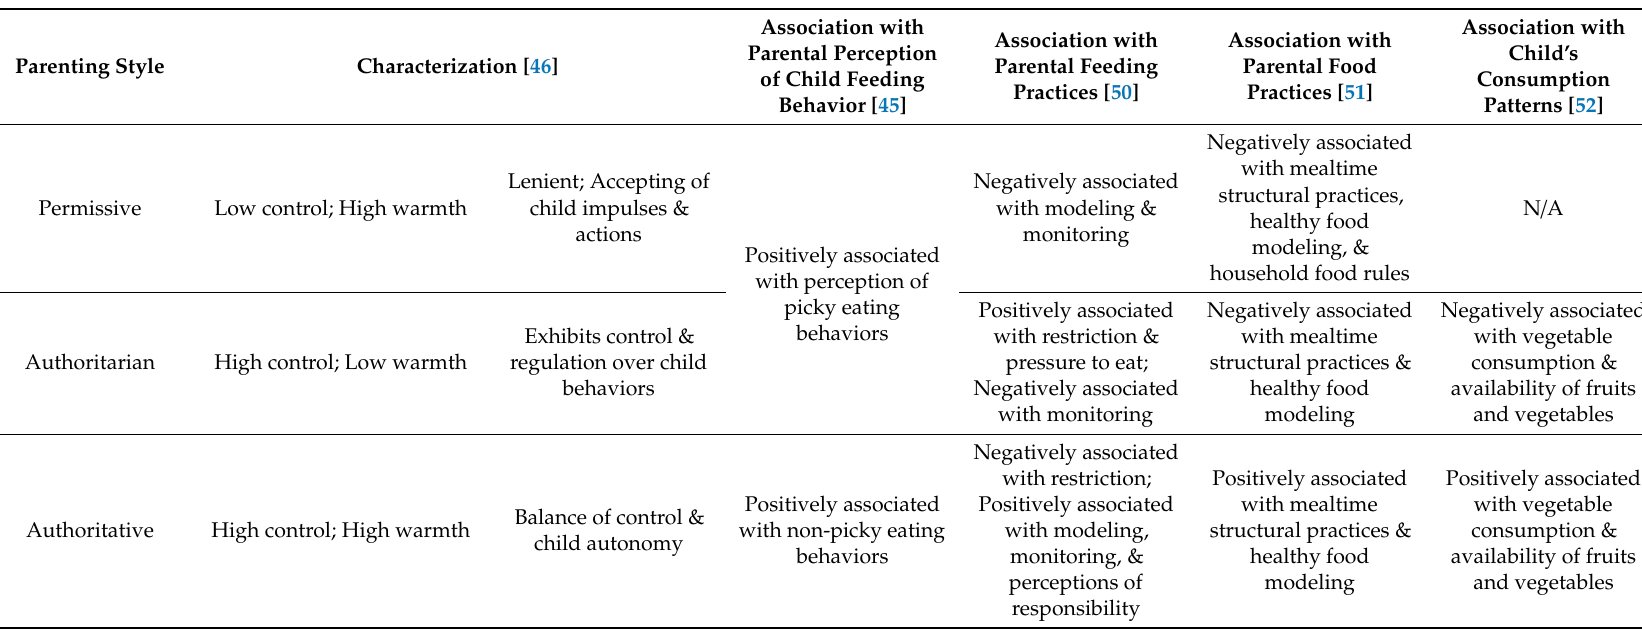
Table 1. Relationship between Parenting Styles and Perception of Child Feeding Behaviors, Parental Feeding Practices, & Consumption Patterns.